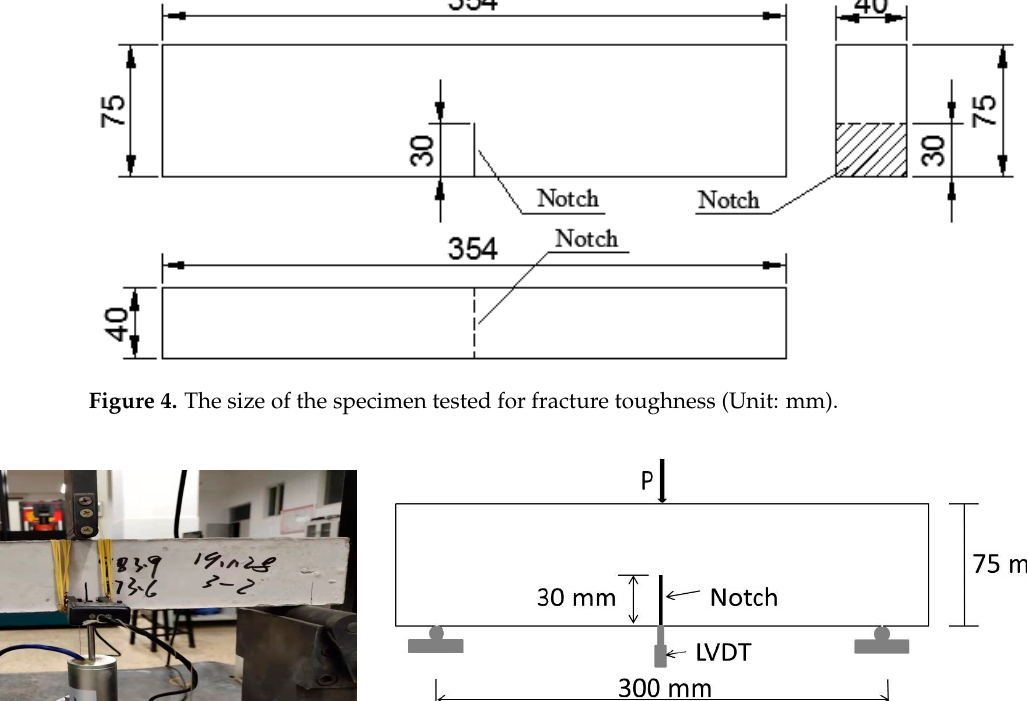
( b ) Figure 6. Single-crack tensile test. ( a ) Diagram of specimen size (Unit: mm); ( b ) photo of the test device. 3.5. Physical and Mechanical Performance Test Bulk density . The apparent density of the GLECC was tested on 50 × 50 × 50 mm 3 cube specimens. After the samples were cured to the test age, the weight of the sample in the dry state of the surface was weighed, and three specimens were tested for each mix proportion. Compressive strength . The specimens used in the compressive strength tests were the same as those used in the bulk density test. The compressive strength test was per- formed after the bulk density test. Here, a loading rate of 0.6 MPa/s was used, and three specimens were tested for each mix proportion [42]. Uniaxial tensile test . Dog-bone specimens were used to test the tensile properties of the GLECC, and the dimensions of the specimens are shown in Figure 7a. The tensile test was carried out on a universal testing machine at a loading rate of 0.5 mm/min. During the tensile test, two LVDTs were fixed on either side of the specimen to record the deformation of the GLECC gauge length, as shown in Figure 7b.